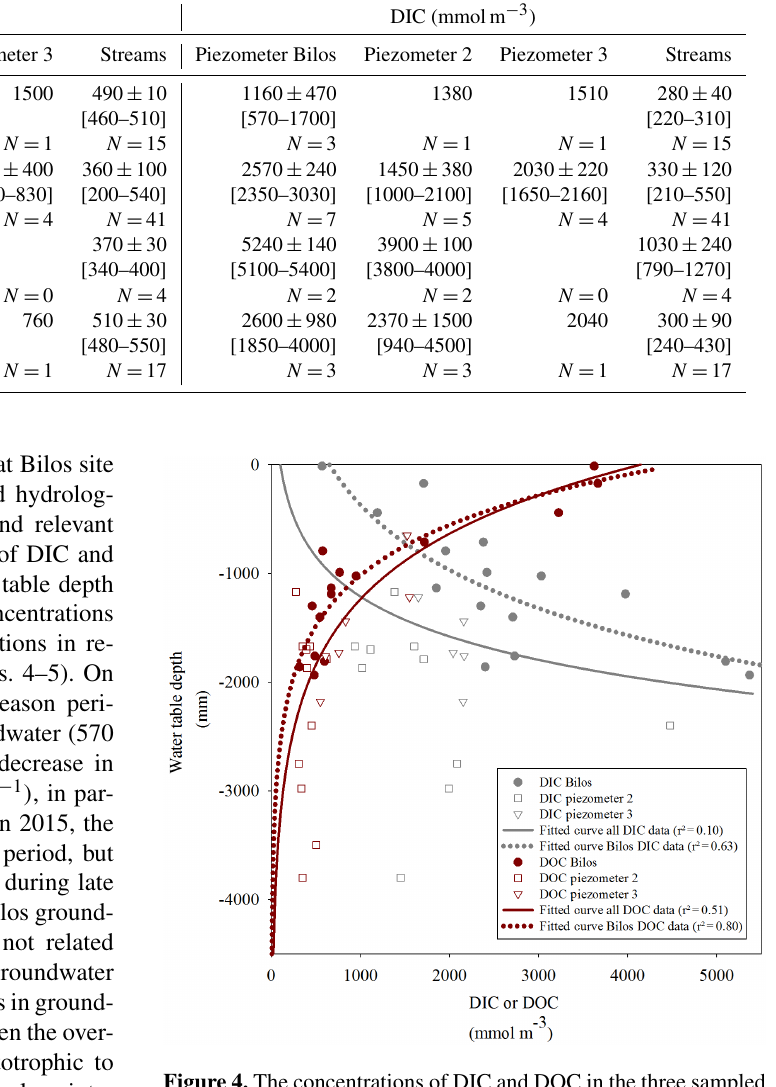
Figure 4. The concentrations of DIC and DOC in the three sampled groundwaters as a function of water table